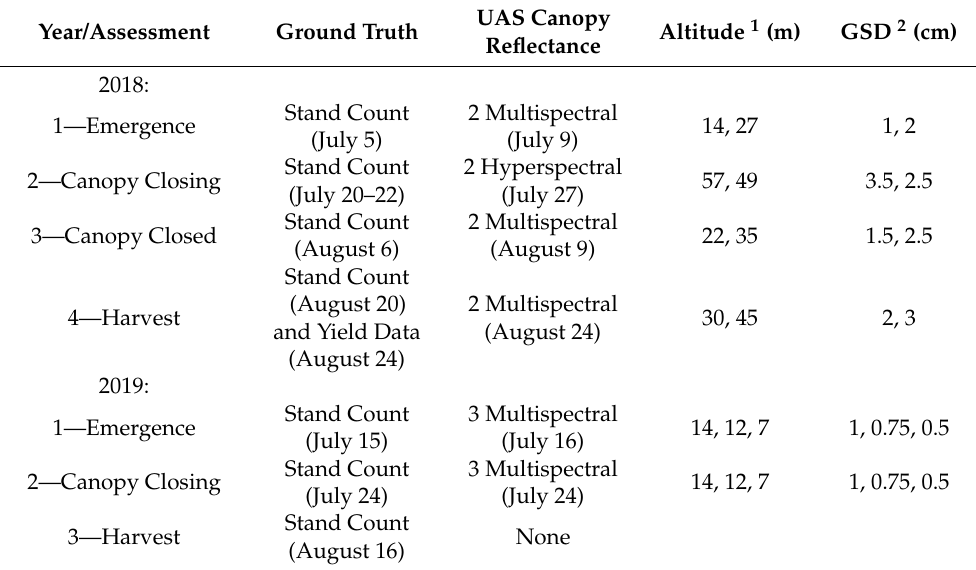
Table 1. Temporal sequence of data collection in the table beet fields in New York, USA in 2018 and 2019.